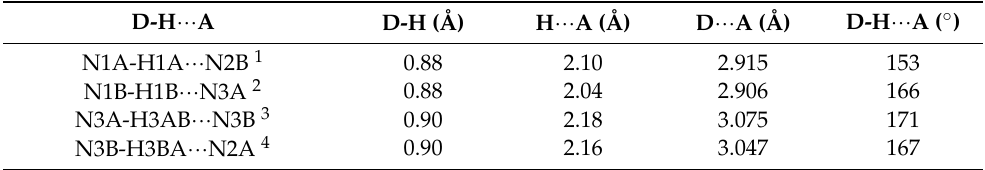
Table 7. Intermolecular H-bond data for P3.